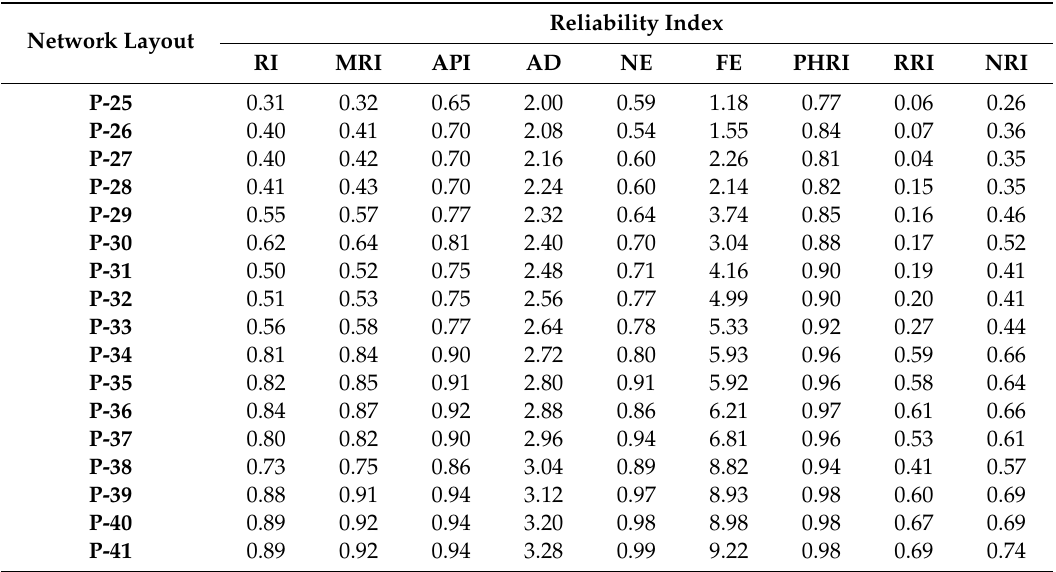
Table 1. Reliability index values of 17 application networks in the base